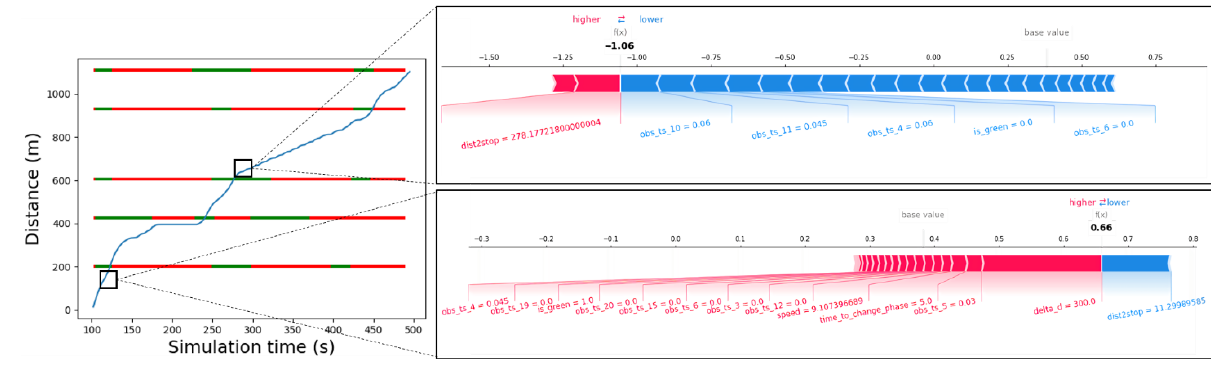
Figure 10. Sample trajectory 1 and its SHAP representation.